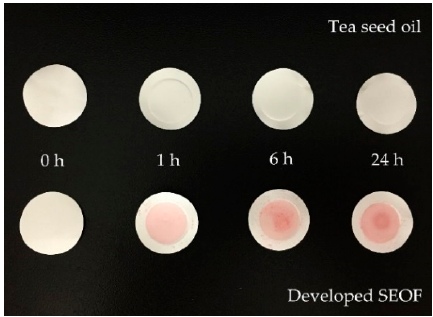
Figure 5. Appearance of membrane after performed in a Franz cell apparatus; tea seed oil ( top ) and SEOF ( down ).